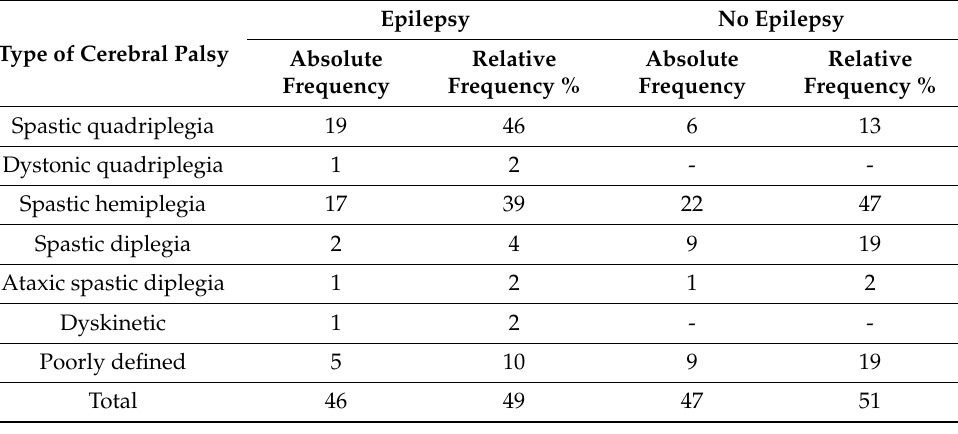
Table 2. Frequency of epilepsy in the children according to the type of CP.